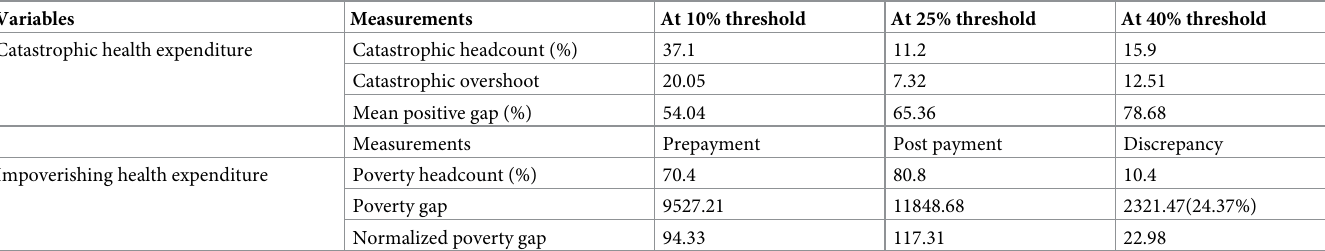
Table 4. Financial hardship of healthcare among households in Debre Tabor town, Ethiopia, 2022.